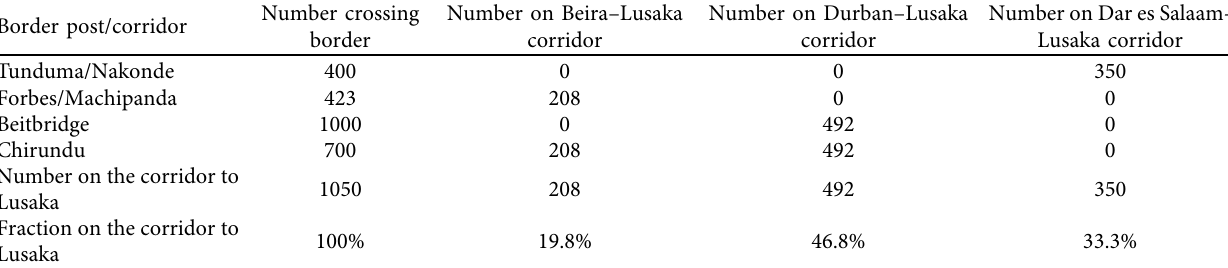
Table 4: Average daily truck volumes crossing border posts connecting the 3 corridors to Lusaka.